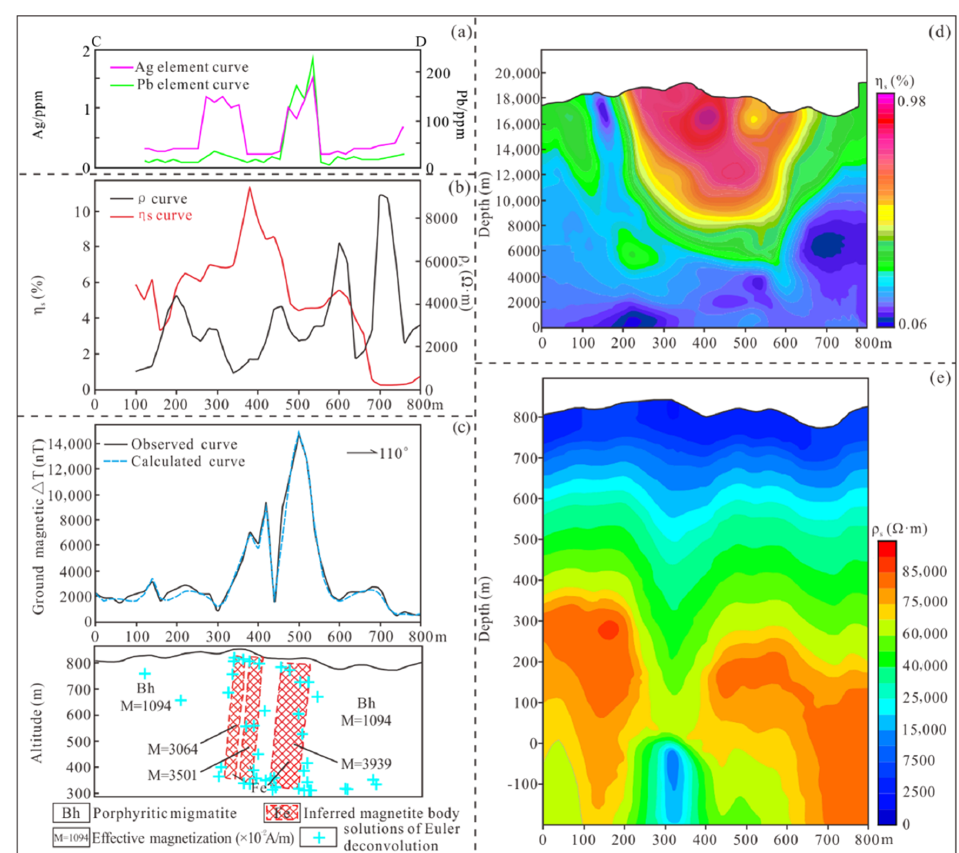
Figure 11. Integrated geophysical profiles of ground surveying of anomaly JDB-8: ( a ) anomalies of Ag and Pb from soil measurements, ( b ) curve of IP central gradient method of ground surveying line 2, ( c ) forward fitting profile to magnetic data ∆ T of ground surveying line 2, ( d ) profile of η s relative intensity by fixed–source sounding for ground surveying line 2, ( e ) CSAMT inversion resistivity